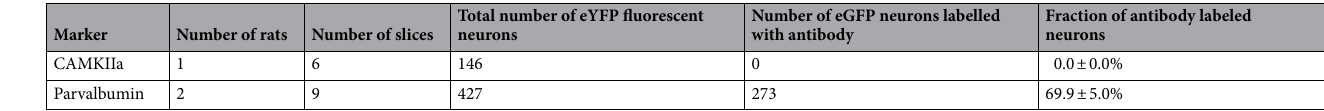
Table 4. Summary of rAAV2-PV -eGFP co-expression in area S1.